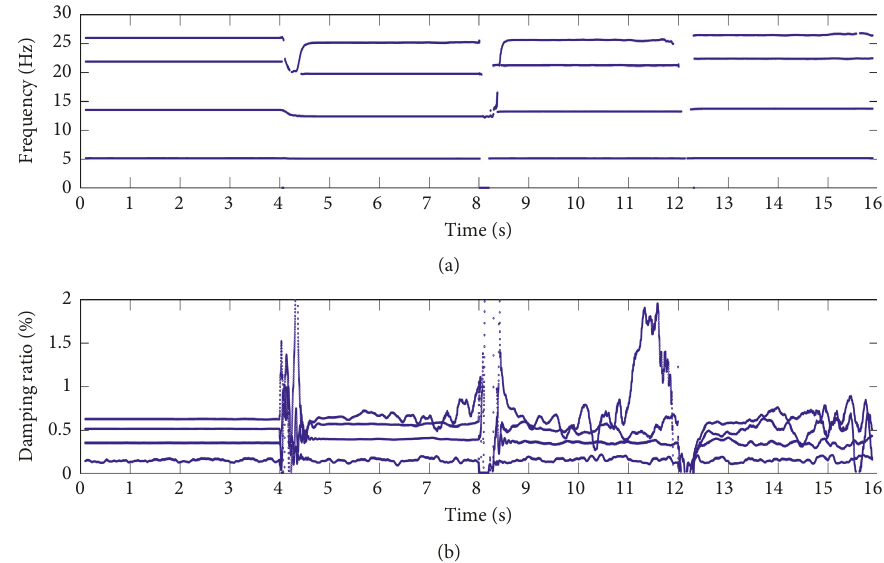
Figure 6: Frequency ( f ∼ f ∼ ξ 1 4 ) and damping ratio ( ξ 1 4 ) identification results of simulation case 1 (SNR (cid:29) 40dB): identification results for (a) natural frequencies using GYAST-RSSI and (b) damping ratios using GYAST-RSSI.